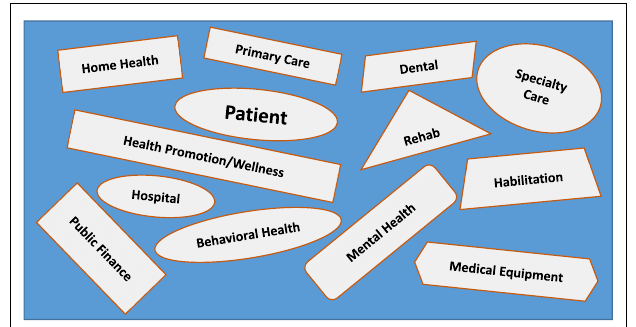
FIGURE 1 | Healthcare for people with intellectual and developmental disabilities .